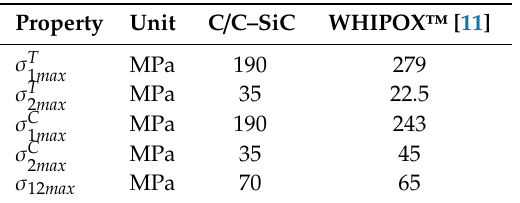
Table 6. Stress limits for stress-based Tsai-Wu failure criterion where superscripts ‘ T ’ and ‘C’ denote tension and compression, respectively.